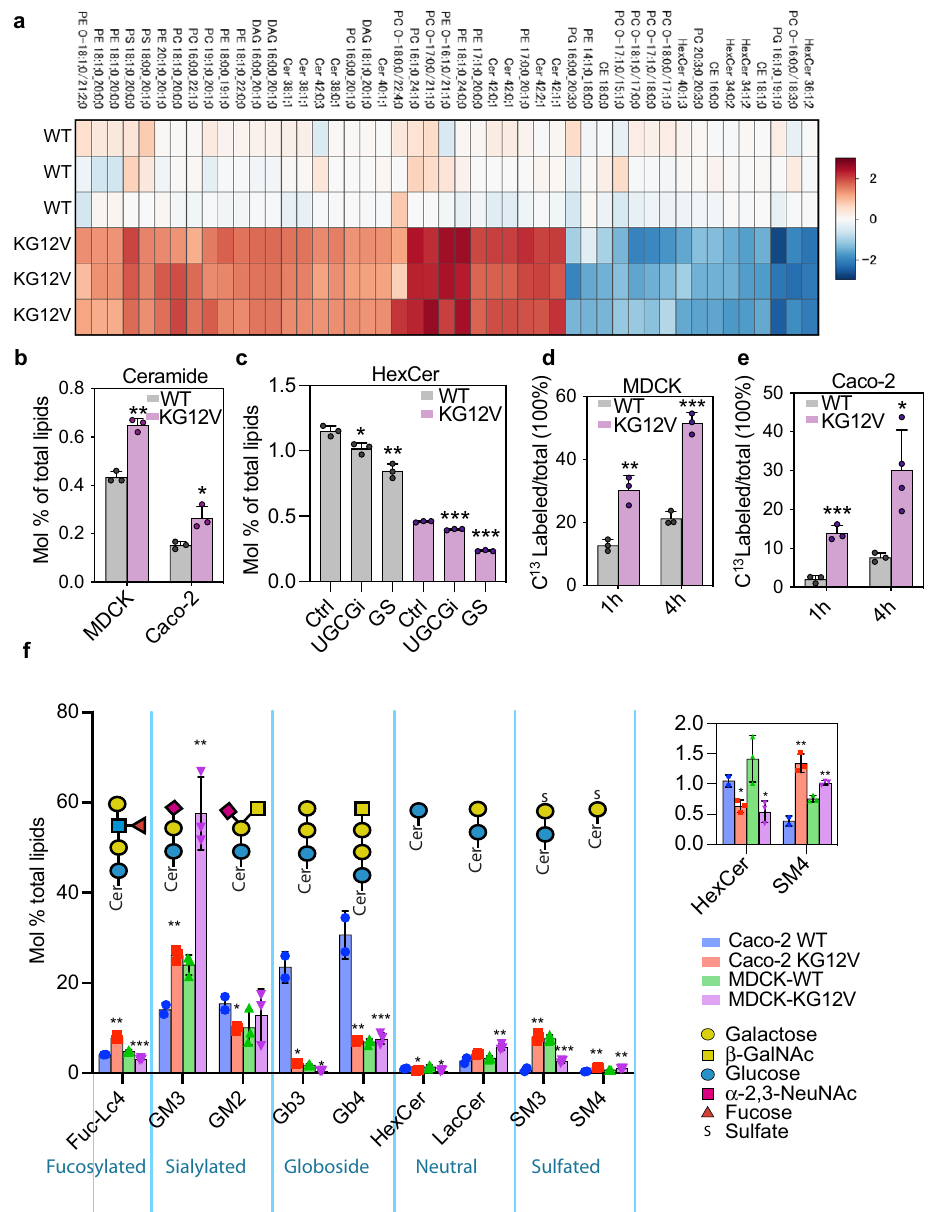
Fig. 3 | KRASG12V expression reprograms the cellular lipidome. Lipidomic analysisofparental(WT)versusGFP-KRASG12V-expressingMDCK,orCaco-2cells: a Heatmap of MDCK lipid species that changed most upon KRASG12V expression, shown as log 2 fold changes (red=increase, blue=decrease). b Molar fractions of ceramide from lipidomic analyses in ( a ). c HexCer levels shown as mean mol% in glucose depleted (GS), or DL-PDMP-treated (UGCGi) WT and KRASG12V- expressing MDCK cells. HexCer includes GlcCer and GalCer, which cannot be